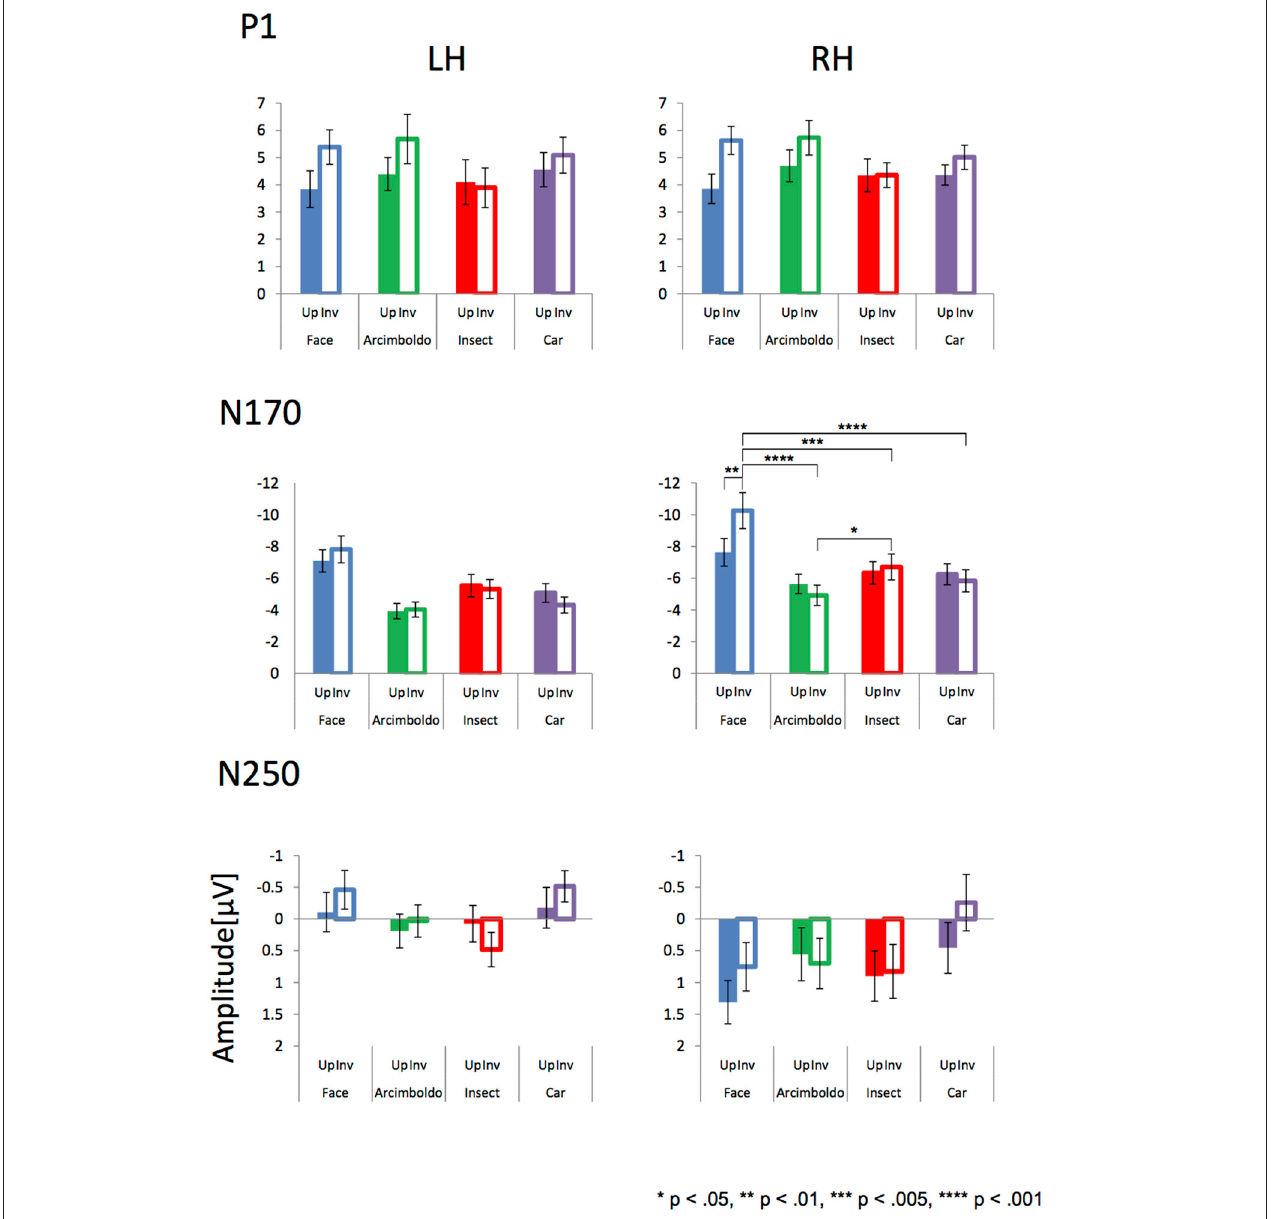
FIGURE 4 | Peak amplitude of the P1 (Top) , N170 (Middle) , and N250 component (Bottom) measured at the left and right pooled occipito-temporal electrode sites (averaged for electrodes P5/P9/PO7 and P6/P10/PO8), displayed for 4 categories in the upright (fill) and inverted (no fill) orientations.